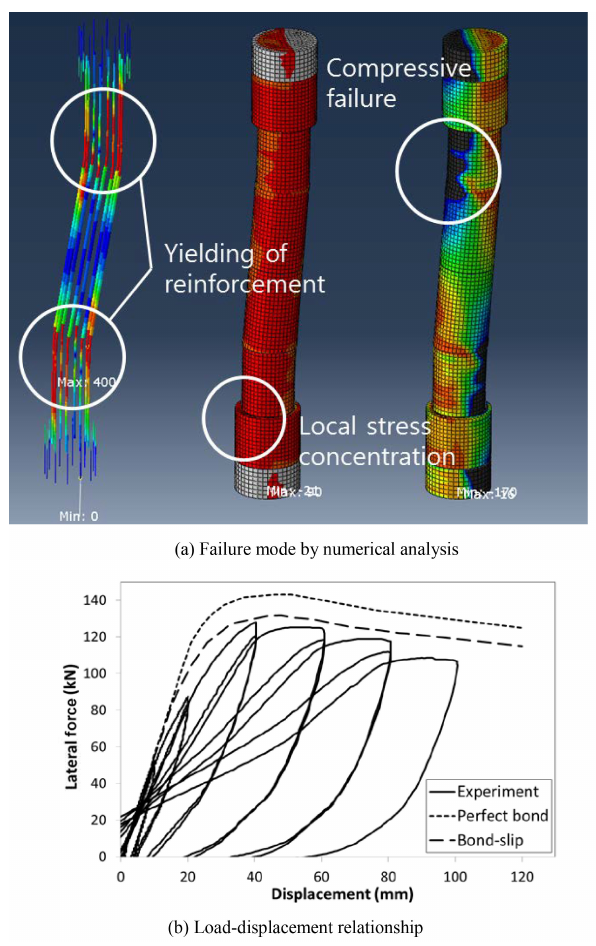
Figure 16. Failure mode and load-displacement relationship of test specimen.